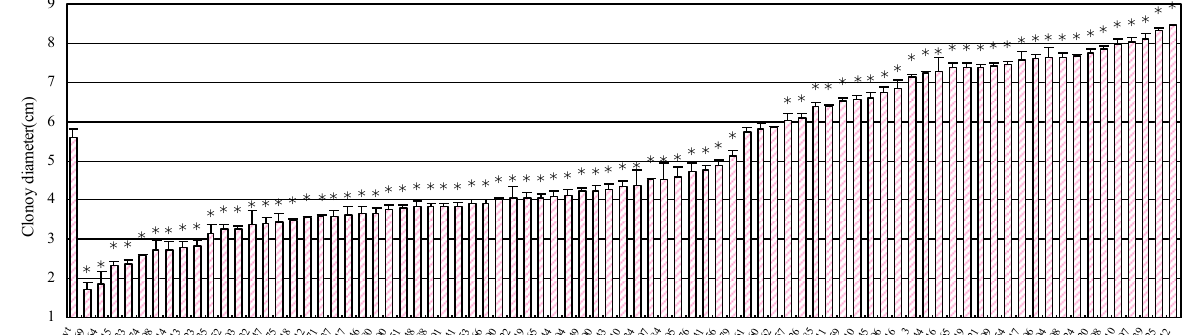
Figure 5. Mean colony diameters of randomly selected REMI Lasiodiplodia theobromae transformants. Legend: wt, JZB 0300251 strain; * indicates significant differences ( P <0.05) between JZB0300251 and a specific transformant, as determined through Duncan’s method. Standard deviations of the means are indicated.